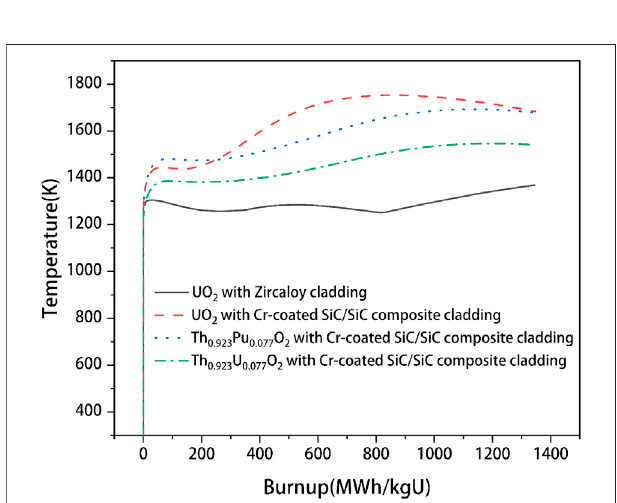
FIGURE 10 | Cladding outer surface hoop strain evolution of the UO 2 fuel with Zircaloy cladding calculated by the FRAPTRAN and CAMPUS codes under the RIA condition.